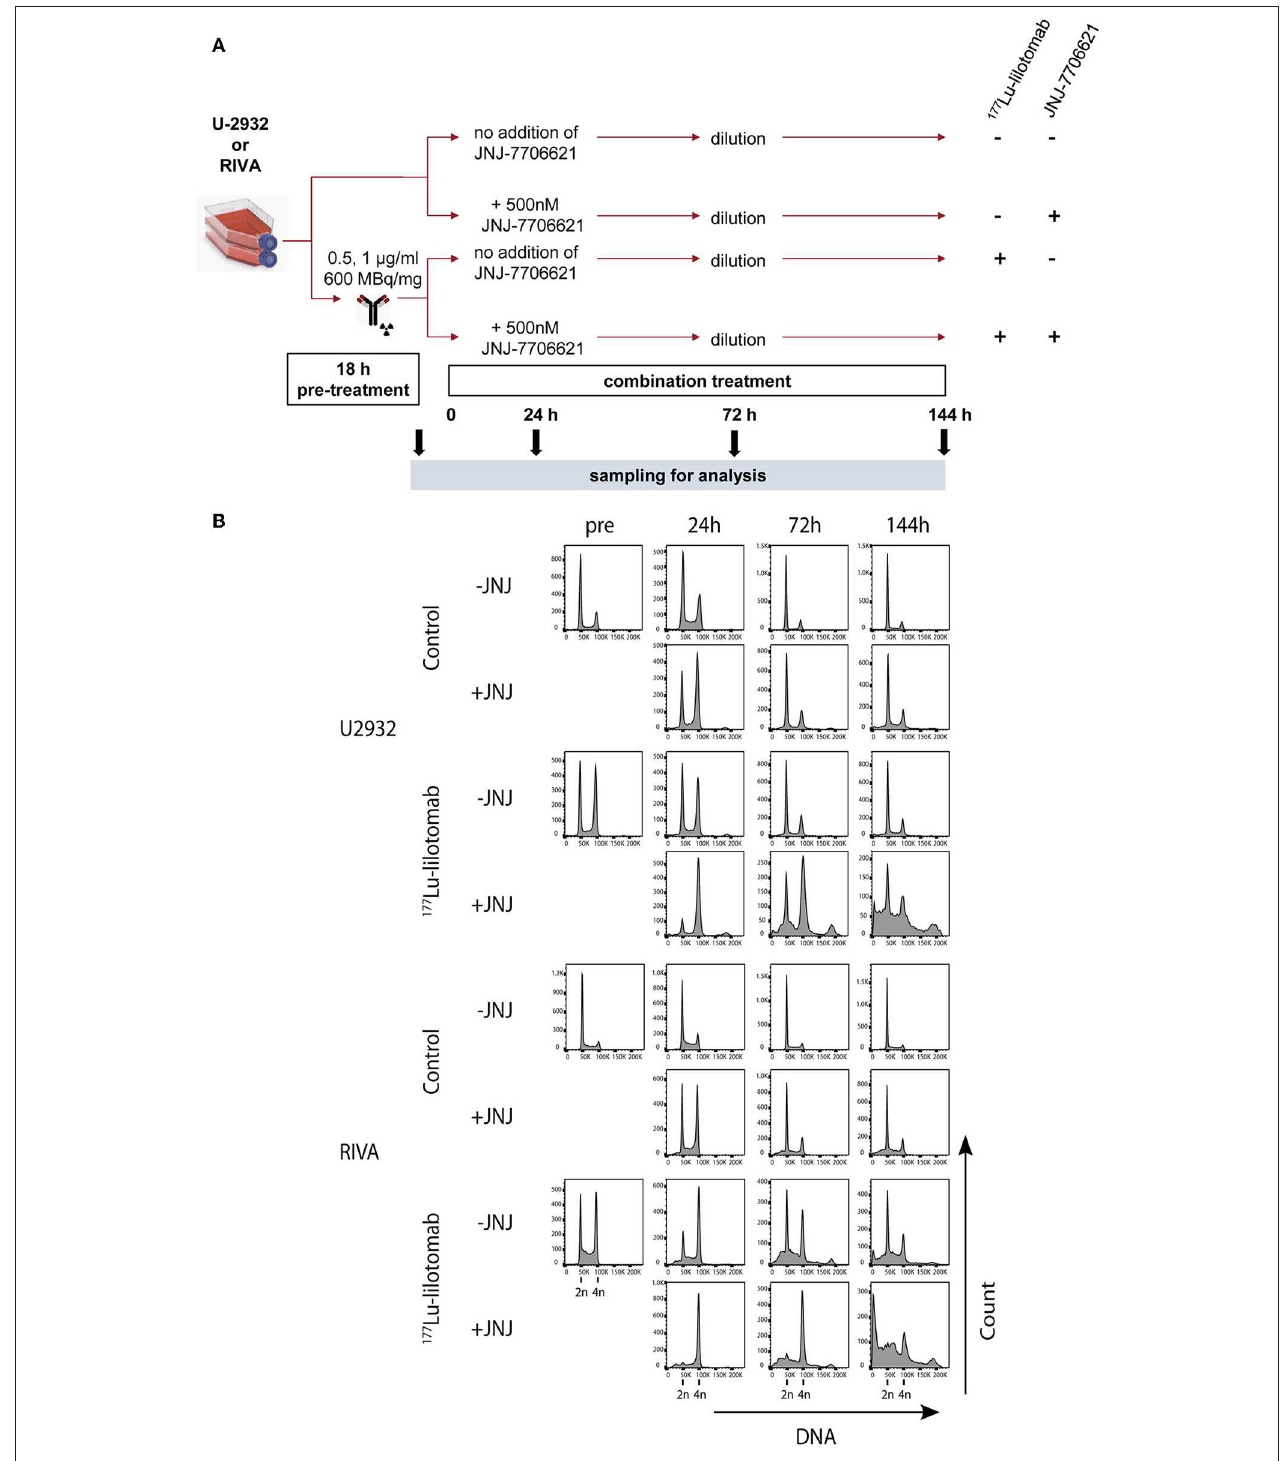
FIGURE 5 | JNJ-7706621 leads to extended G2/M arrest and endoreduplication in 177 Lu-lilotomab satetraxetan treated cells. (A) Outline of experiment. U-2932 and RIVA cells were treated as in Figure 1 with indicated doses of 177 Lu-lilotomab satetraxetan. JNJ-7706621 was added to treated and untreated cells to a final concentration of 500nM. Samples were harvested for flow analysis before (pre) and 24, 72, and 144h after adding inhibitor. After harvesting 72h sample cultures were replenished with medium containing inhibitor. Before fixation, cells were stained with Pacific Blue in order to discriminate between live and dead cells. FxCycleFar Red was used to stain DNA. (B) DNA histograms showing cell cycle distribution in U-2932 (upper panels) and RIVA (lower panels). Data shown are representative of two independent experiments.